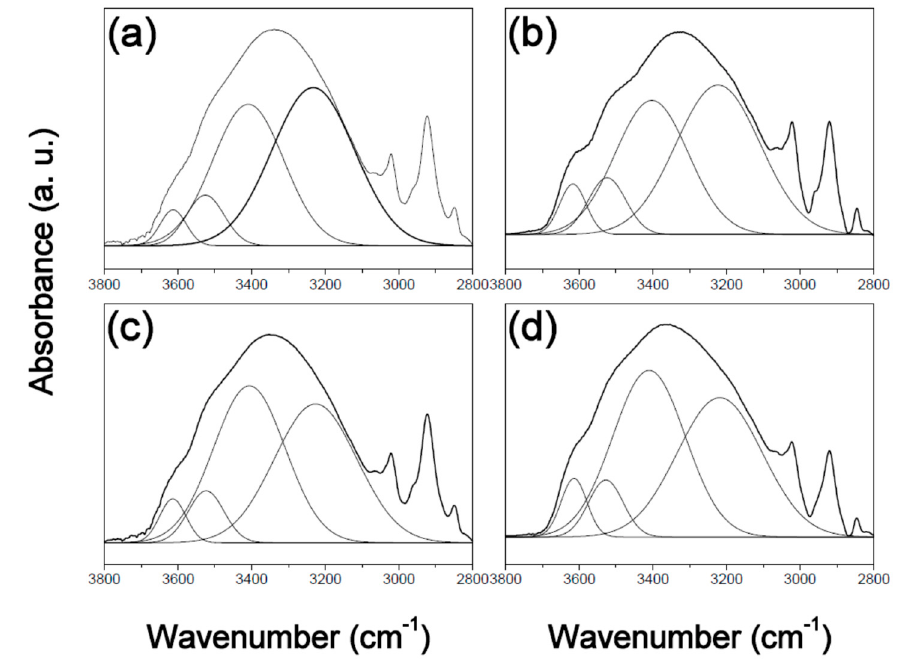
Figure 1. Fourier-transforminfrared (FT-IR)spectra of poly(vinyl phenol) prepared in tetrahydrofuran (PVPh-T) thermally treated at 180 °C for ( a ) 0, ( b ) 1, ( c ) 4, and ( d ) 8h, overlaid with Gaussian-fitted curves.